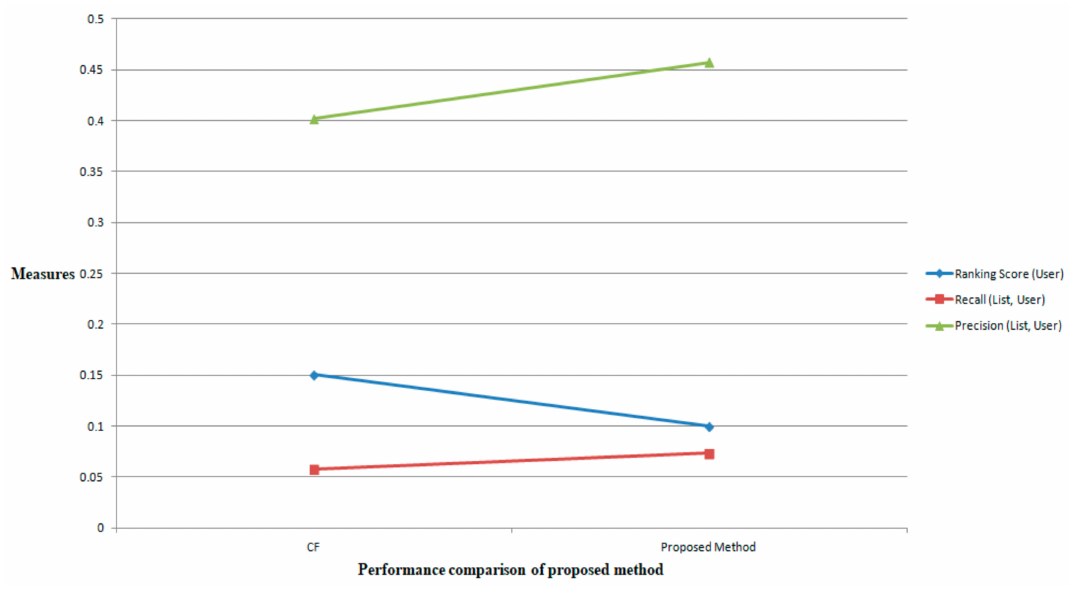
Figure 9. Performance comparisons— Recall , Precision , and Ranking Score